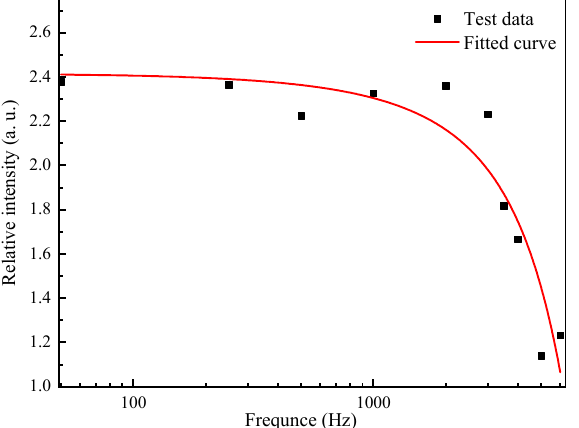
Figure 12. Plot of demodulated signal intensity versus sound wave signal frequency.